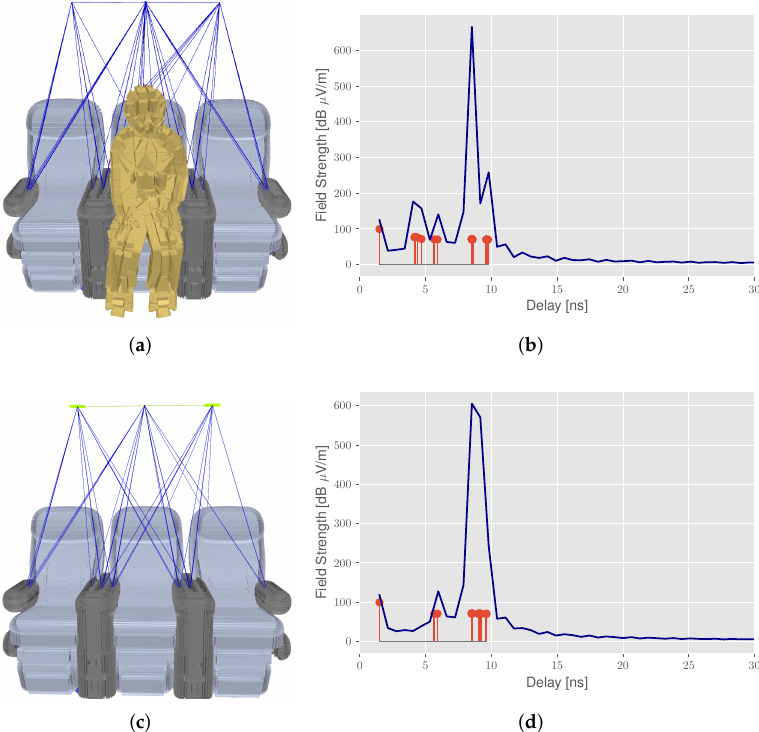
Figure 3. Radio propagation simulation with deterministic ray tracing to explore the multipath prop- agation of signals in the aircraft cabin: ( a ) seat 2 occupied with ( b ) corresponding CIR, ( c ) reference measurement (no seat occupied) with ( d ) corresponding CIR. The CIR plots show the propagation paths or multipath components (red) and the bandlimited reconstructed CIR (blue